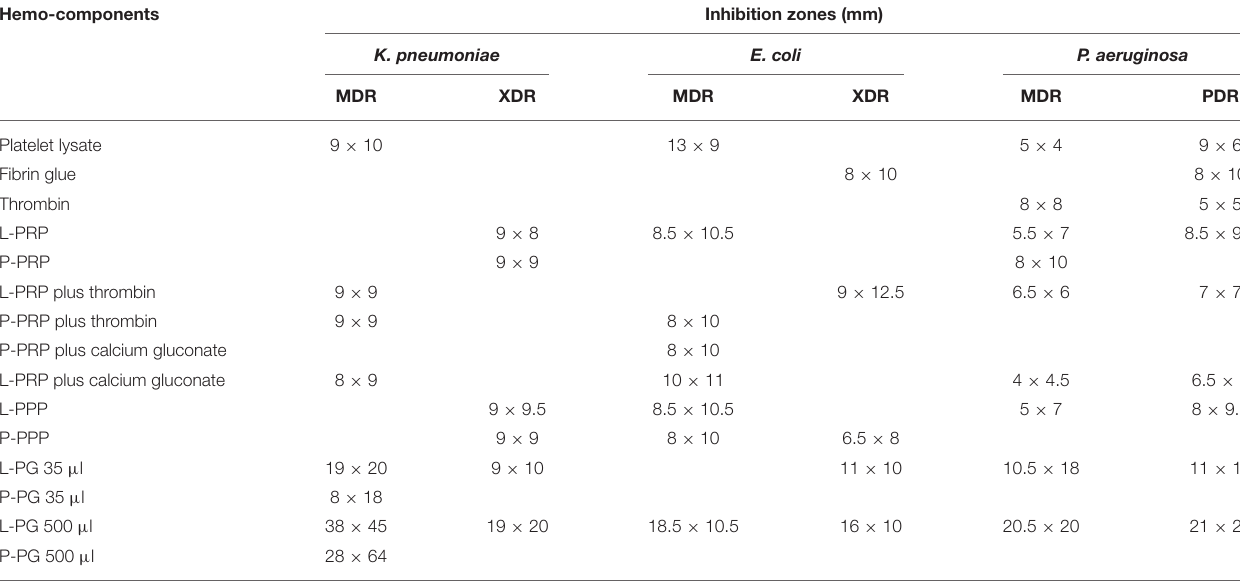
TABLE 4 | Inhibition zones (mm) recorded for Gram-negative bacteria after 18h of incubation using the Kirby–Bauer method. Hemo-components